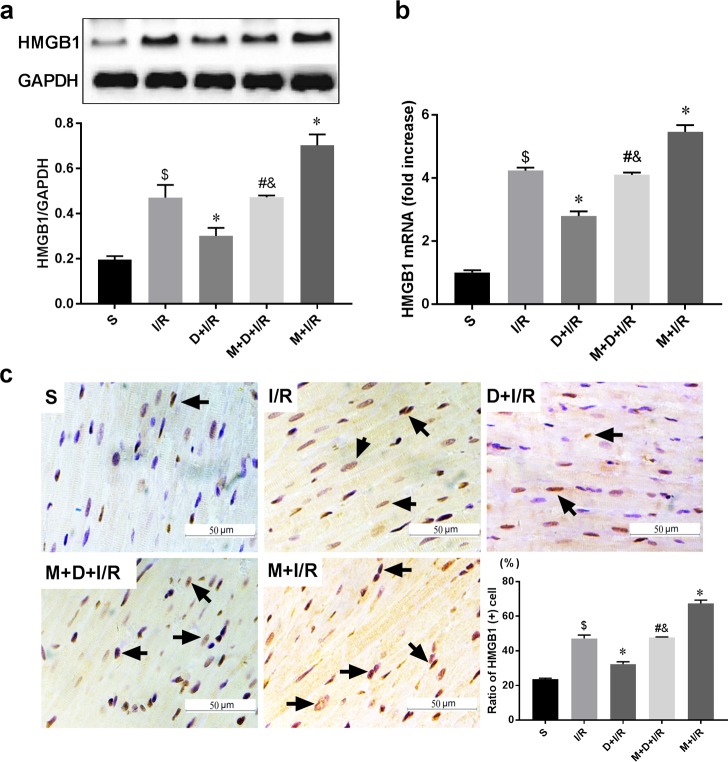
Blockade of the α7nAChR reverses DEX-induced downregulation of HMGB1 during I/R.To explore the involvement of α7nAChR, methyllycaconitine (MLA, α7nAChR antagonist) was administered. HMGB1 protein levels in the left ventricles were measured using Western blot (a) and HMGB1 mRNA levels were assessed by q-RT-PCR (b). Representative images of immunohistochemical staining for HMGB1 and quantitative results (c). Arrows indicate HMGB1-positive cells. Scale bar = 50 μm; n = 6 per group; $ p<0.05 vs. S; *p < 0.05 vs. I/R; #p < 0.05 vs. D+I/R; &p < 0.05 vs. M+I/R. S: sham operation; I/R: myocardial ischemia-reperfusion; D: dexmedetomidine; M: methyllycaconitine.